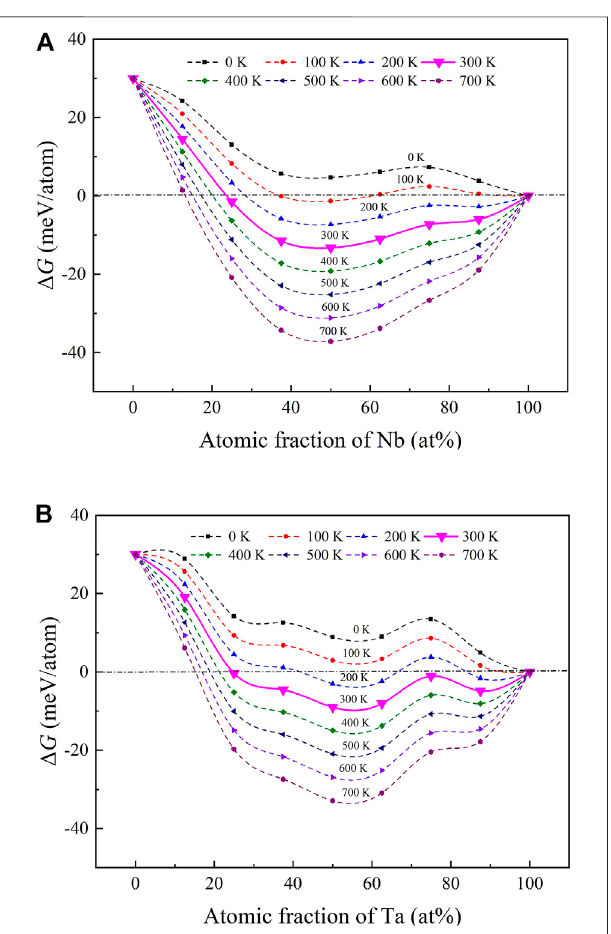
FIGURE 4 | Gibbs free energies of (A) β -TiNb and (B) β -TiTa